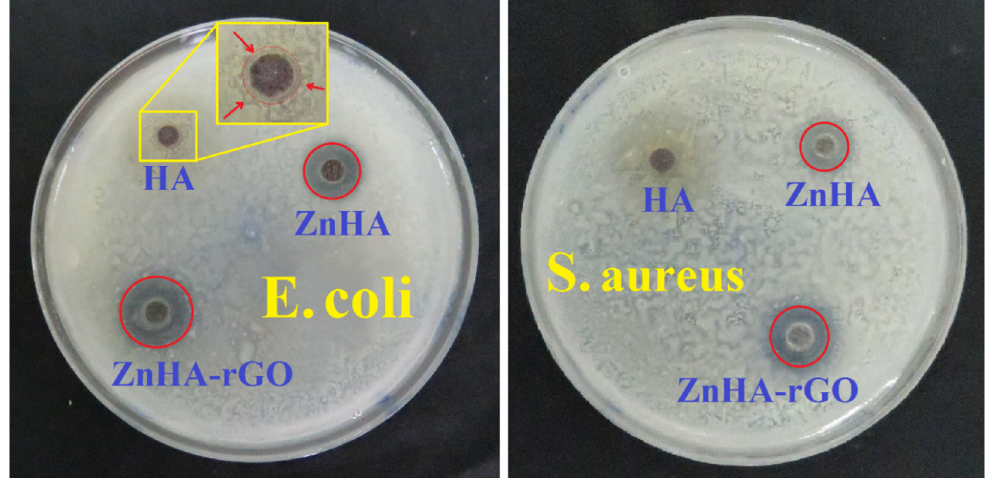
Figure 7. Disk diffusion tests for the evaluation of antibacterial activity of HA, ZnHA, and ZnHA- rGO nanoparticles against the E. coli and S. aureus strains. The zone of inhibition is highlighted with a red circle indicating a noticeable antibacterial effect.